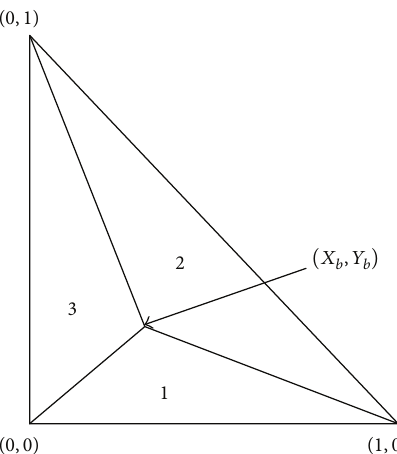
Figure 1: Schematic diagram showing the domains for the bubble functions for a reference triangle cell